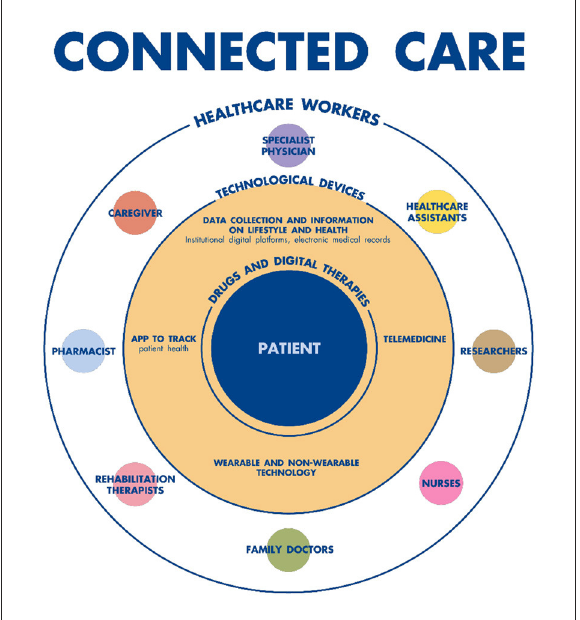
FIGURE1 Connected care operating